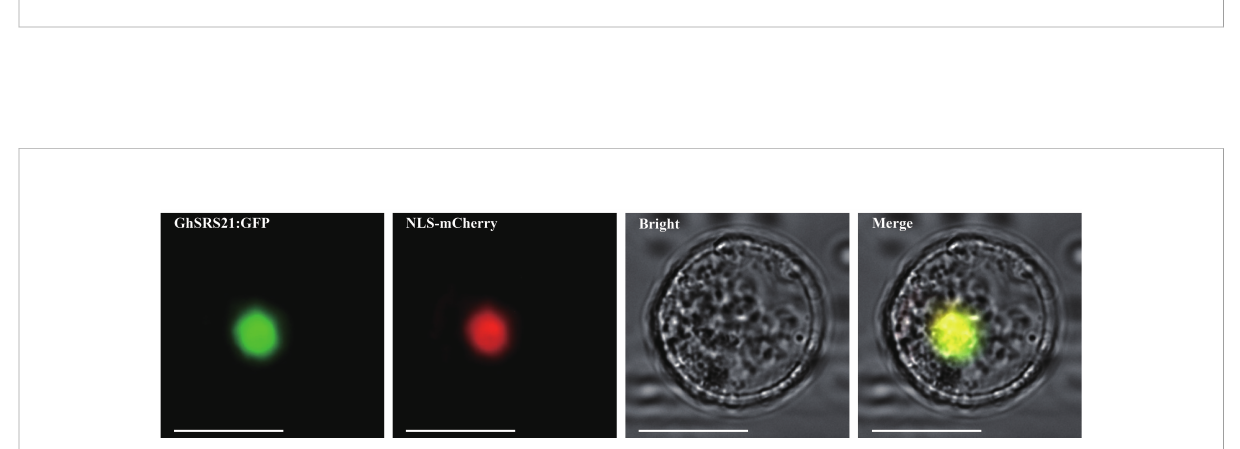
FIGURE 5 Expression patterns of GhSRS family members under salt and drought stress. Color intensity displayed in the heatmap are the Log 2 transformed RPKM gene expression value. The origin FPKM values were showed in the squares. CK represents the control